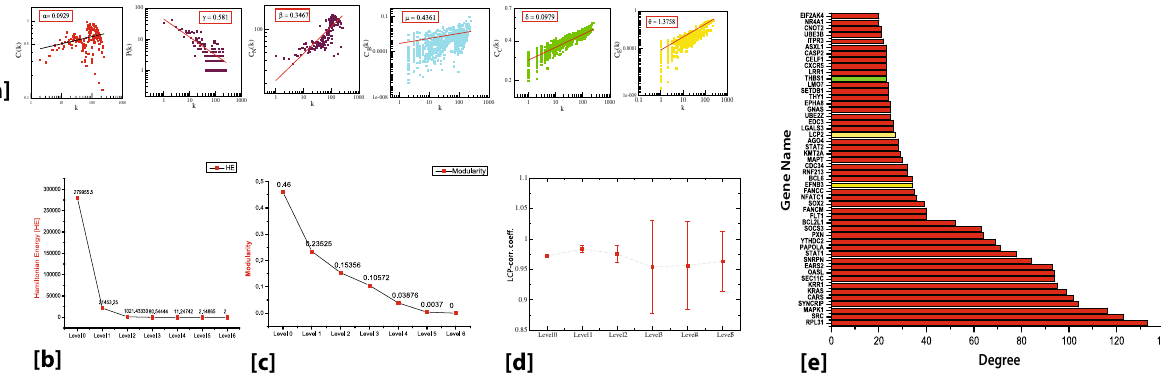
Figure 3. ( a ) The behaviours of degree distributions (P(k)), clustering coefficient (C(k)), neighborhood connectivity (C N (k)), betweenness (C B (k)), closeness (C C (k)) and eigen-vector (C E (k)) measurements as a function of degree k for TS network. ( b ) Corresponding Hamiltonian Energy (HE) as a function of levels of organization. ( c ) Corresponding modularity Q N as a function of levels of organization ( d ) Variation in the calculated average LCP-corr for TS network as a function of network-level. ( e ) Characterization of top fifty leading hubs of the network by degrees. EFNB3 and LCP2 are the key regulators denoted by yellow color and THBS1 are the signature gene of T2DM denoted by green